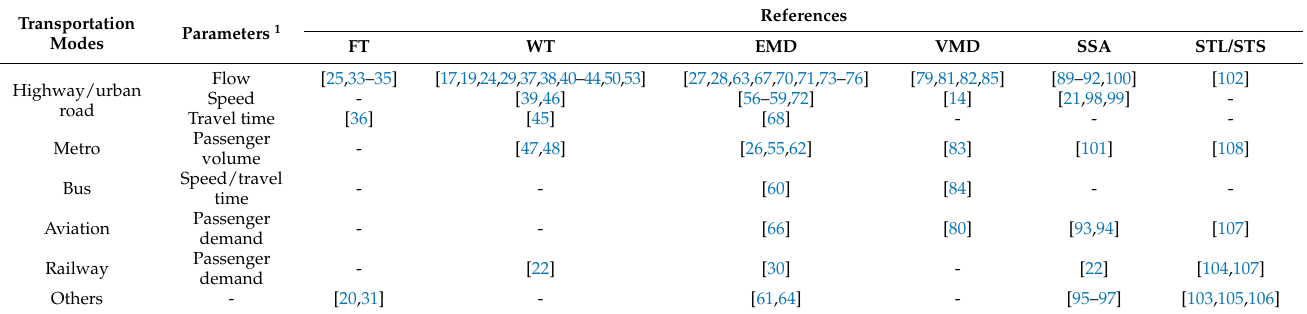
Table 3. Summary of applications in various domains.